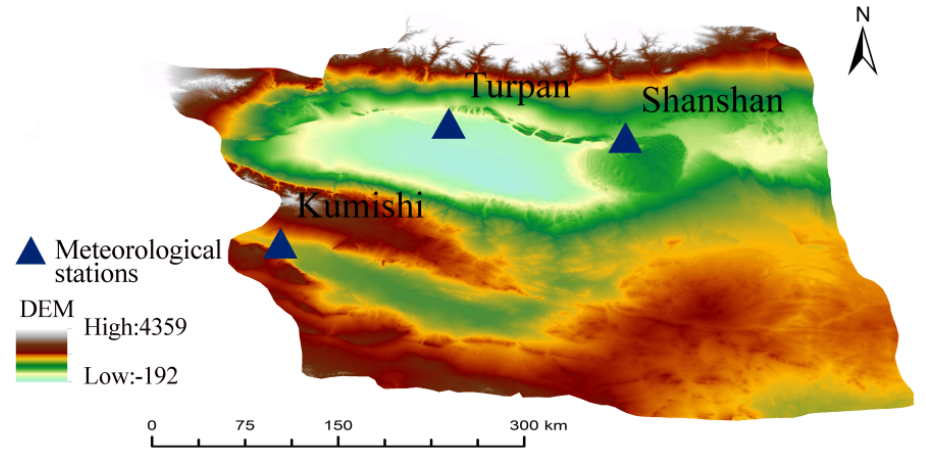
Figure 1. Location map showing topography of study area.